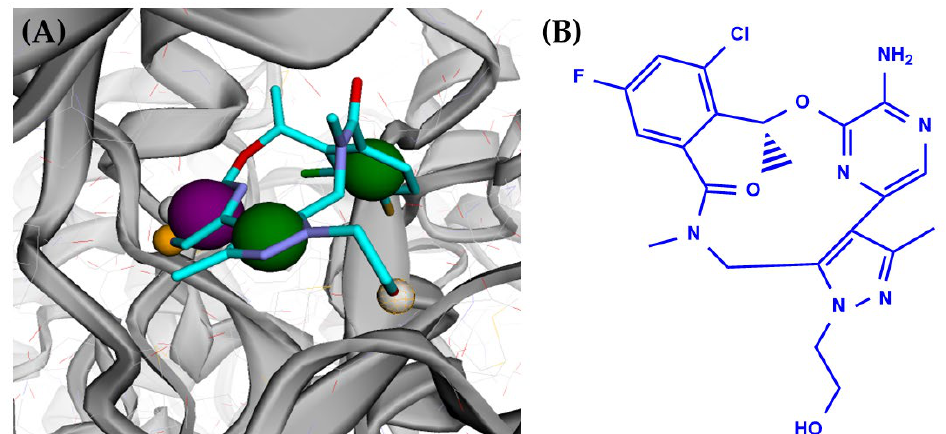
Figure 1. ( A ) Ligand-based pharmacophore generated from the AXL kinase protein (PDB_ID: 5U6B) and the inhibitor obtained using the Pharmit web server and ( B ) 2D structure of the inhibitor molecule in the AXL kinase crystal structure used for pharmacophore generation.